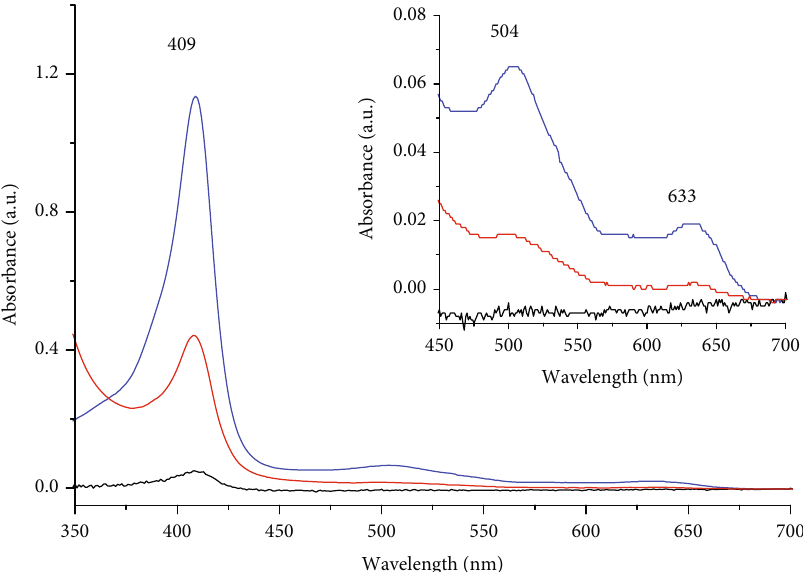
Figure 3: Comparison between the absorbance for 6 μ M met-aquo Mb solution (blue line) with the immobilized protein on collagen measured by re fl ectance (red line) and absorption (black line). The inset shows a clearer view of the 450-700nm